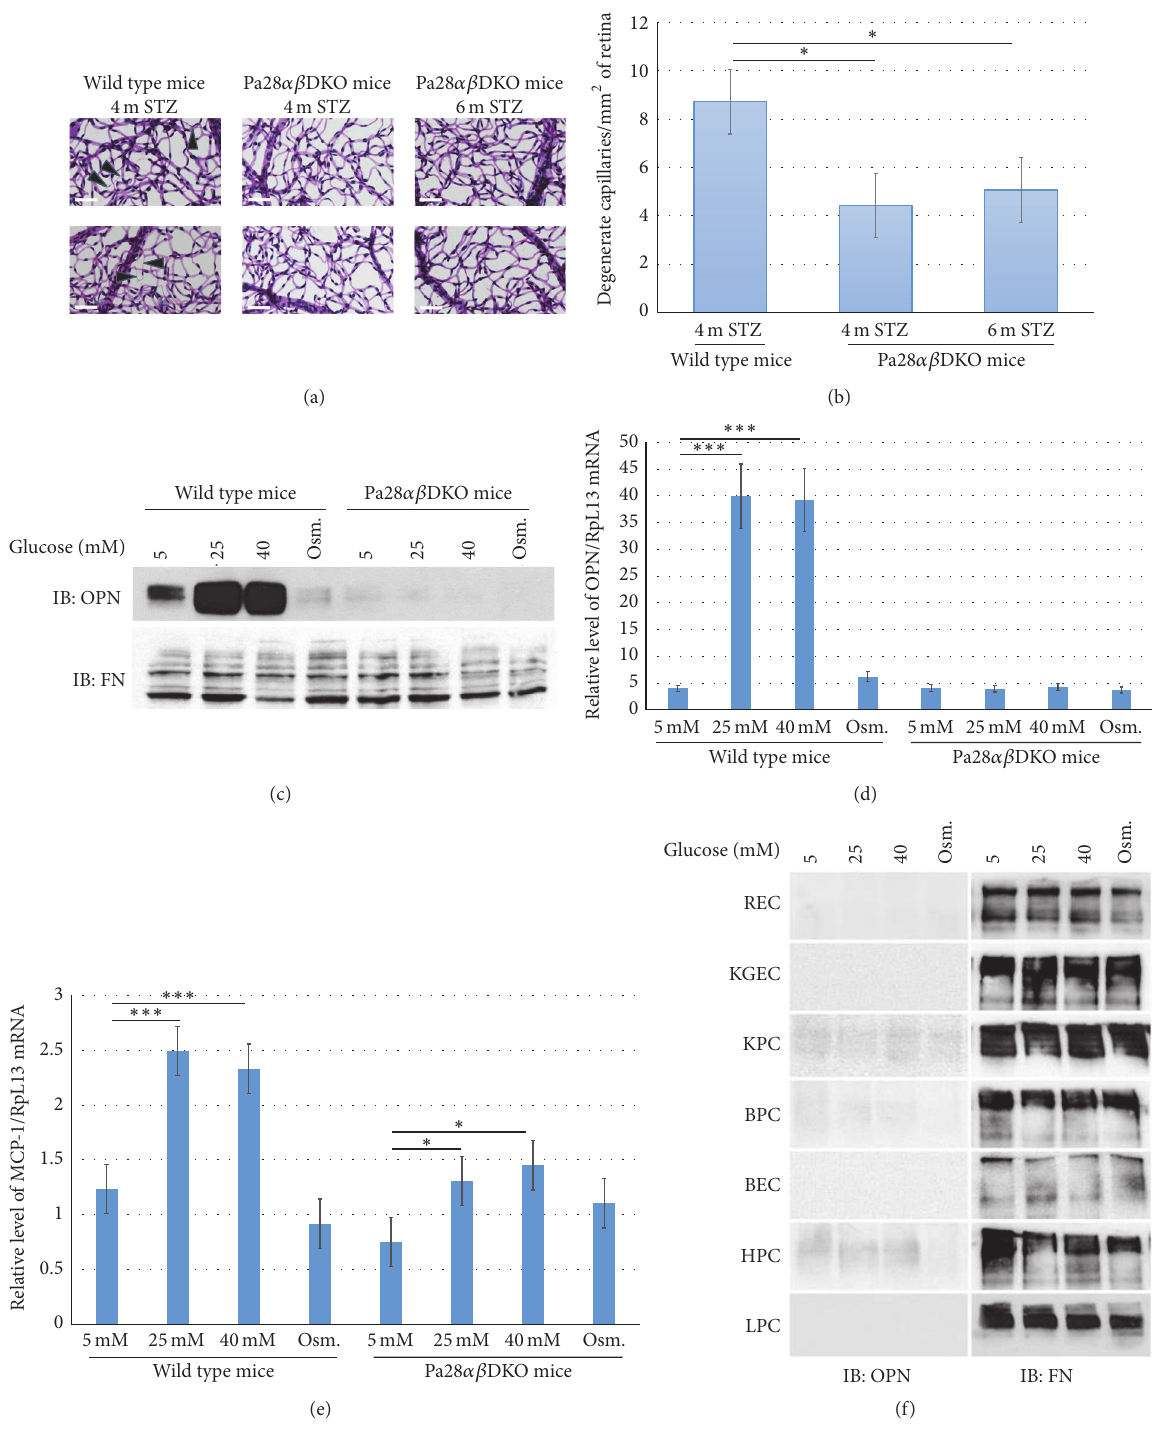
Figure 5: PA28 𝛼 and PA28 𝛽 regulate the diabetic retinal microvascular injury. (a) Light microscopic images of the flat mounted retinae from wild type and Pa28 𝛼𝛽 DKO mice following four or six months of STZ injection. The arrowheads point to the degenerate capillaries. Scale bars, 10 𝜇 m. (b) Quantitation of the number of degenerate capillaries in wild type/STZ and Pa28 𝛼𝛽 DKO/SZT mice. (c) Western blot analysis of the conditioned media of cultured wild type and Pa28 𝛼𝛽 DKO RPC under different glucose conditions and osmolarity treatment. (d) qPCR analysis of OPN and (e) MCP-1 mRNA in wild type and Pa28 𝛼𝛽 DKO RPC under different glucose concentrations. (f) Western blot analysis of OPN and FN in the conditioned media obtained from various vascular and perivascular cell types under different glucose conditions. Results presented as mean ± SEM. ∗ 𝑝 < 0.05 , ∗∗∗ 𝑝 < 0.001